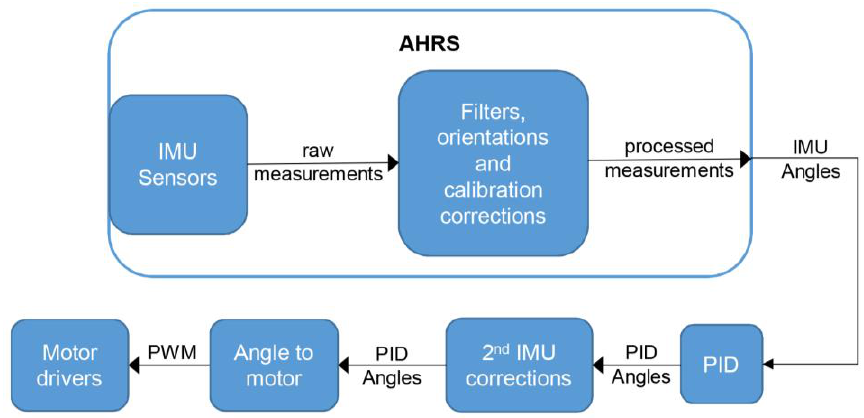
Figure 4. Control loop of the gimbal controller.